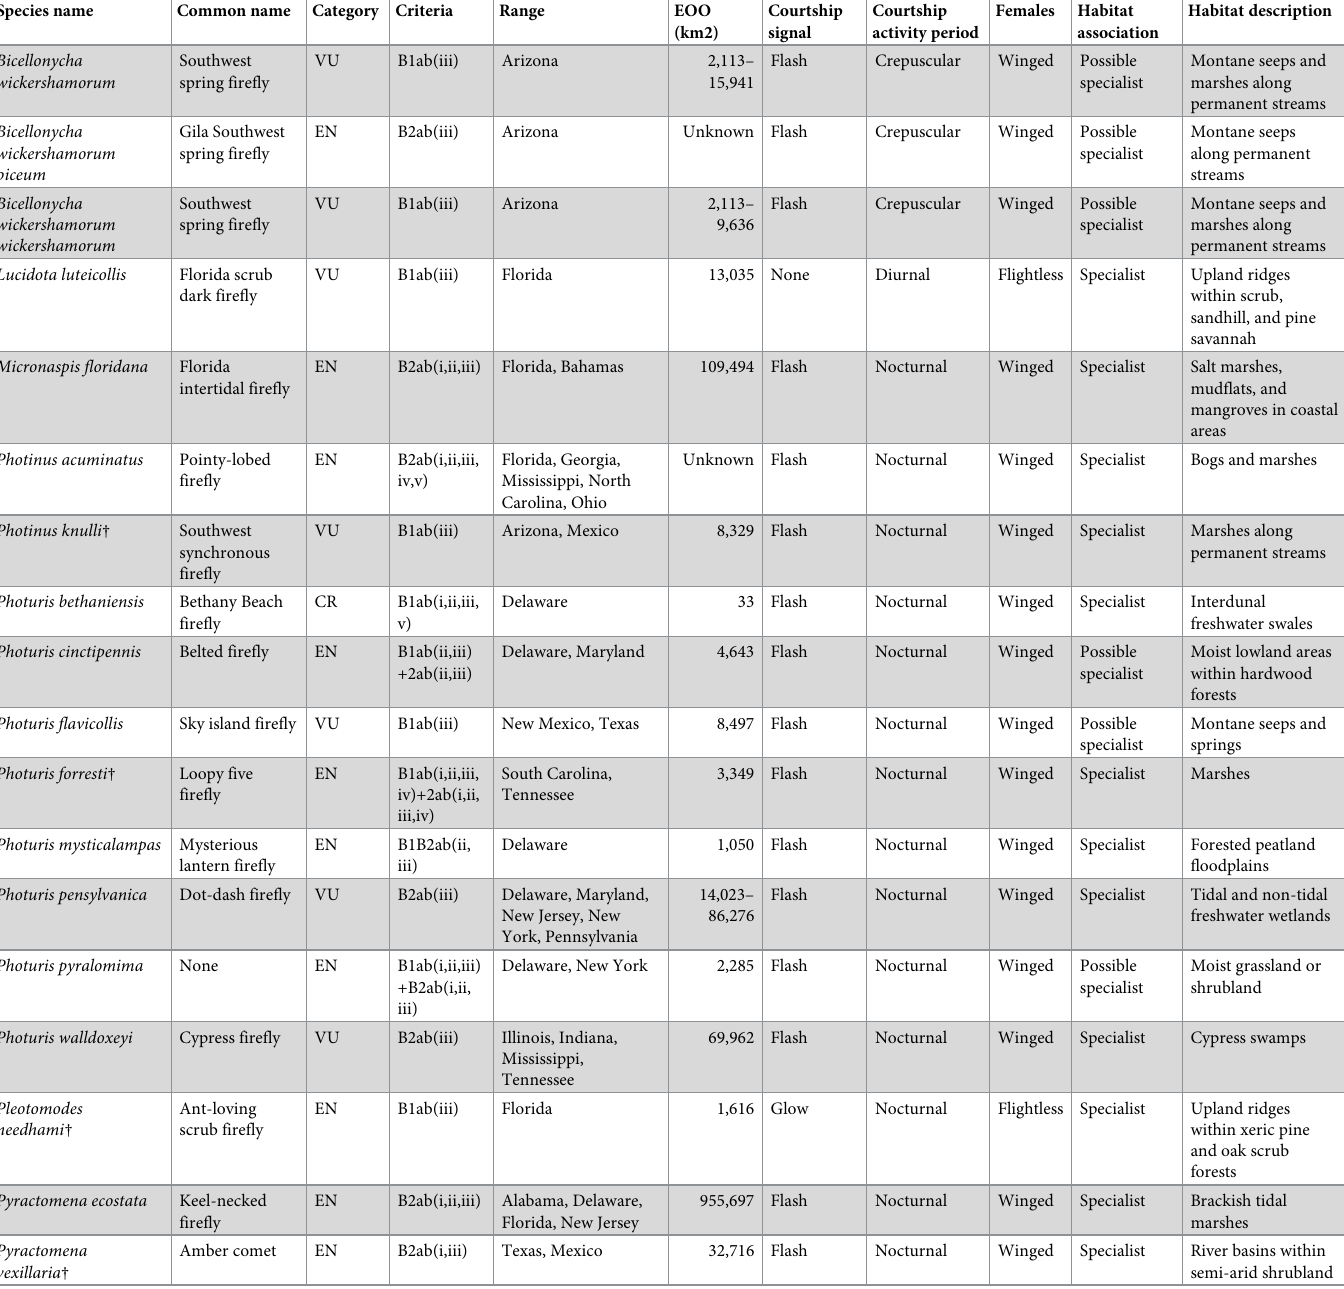
Table 2. Ecology and life history characteristics of 18 threatened firefly species in the U.S. and Canada.